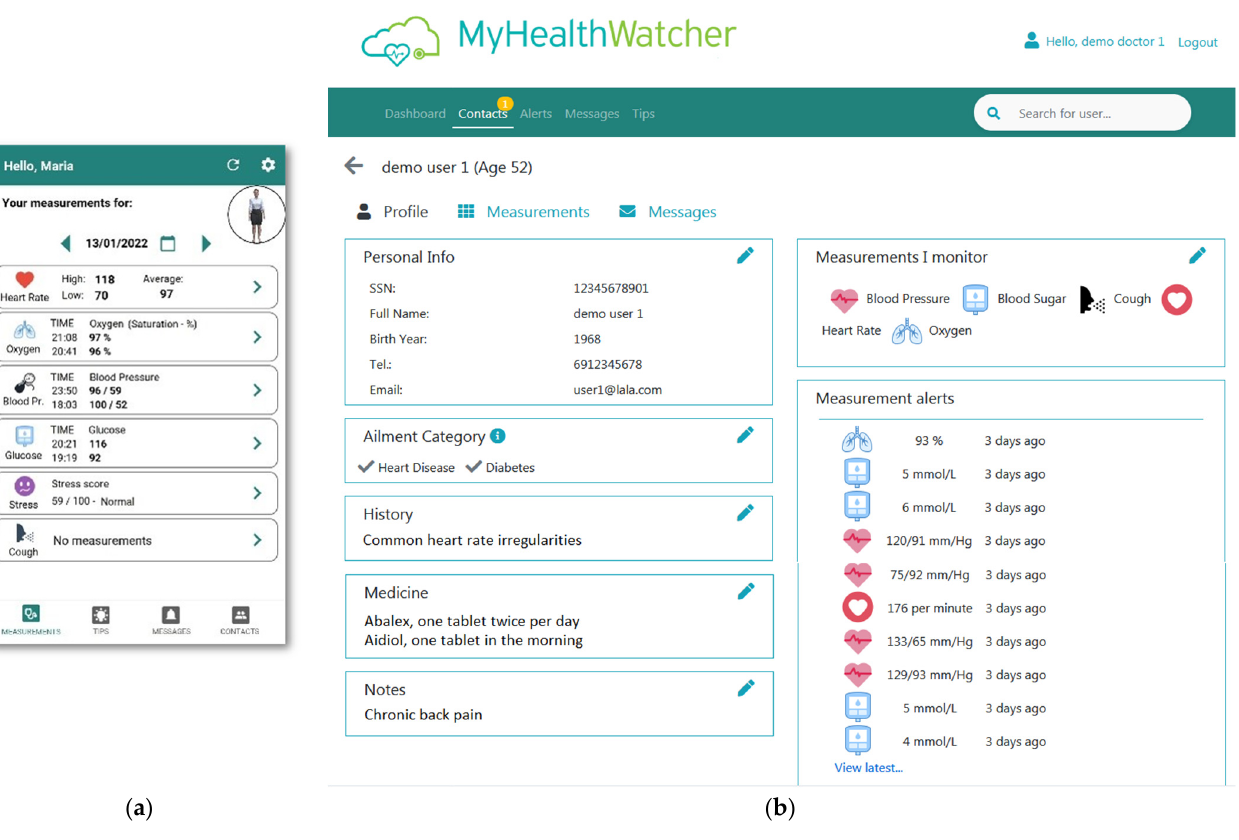
Figure 2. ( a ) Mobile app. ( b ) Secondary user side example—patient’s profile view